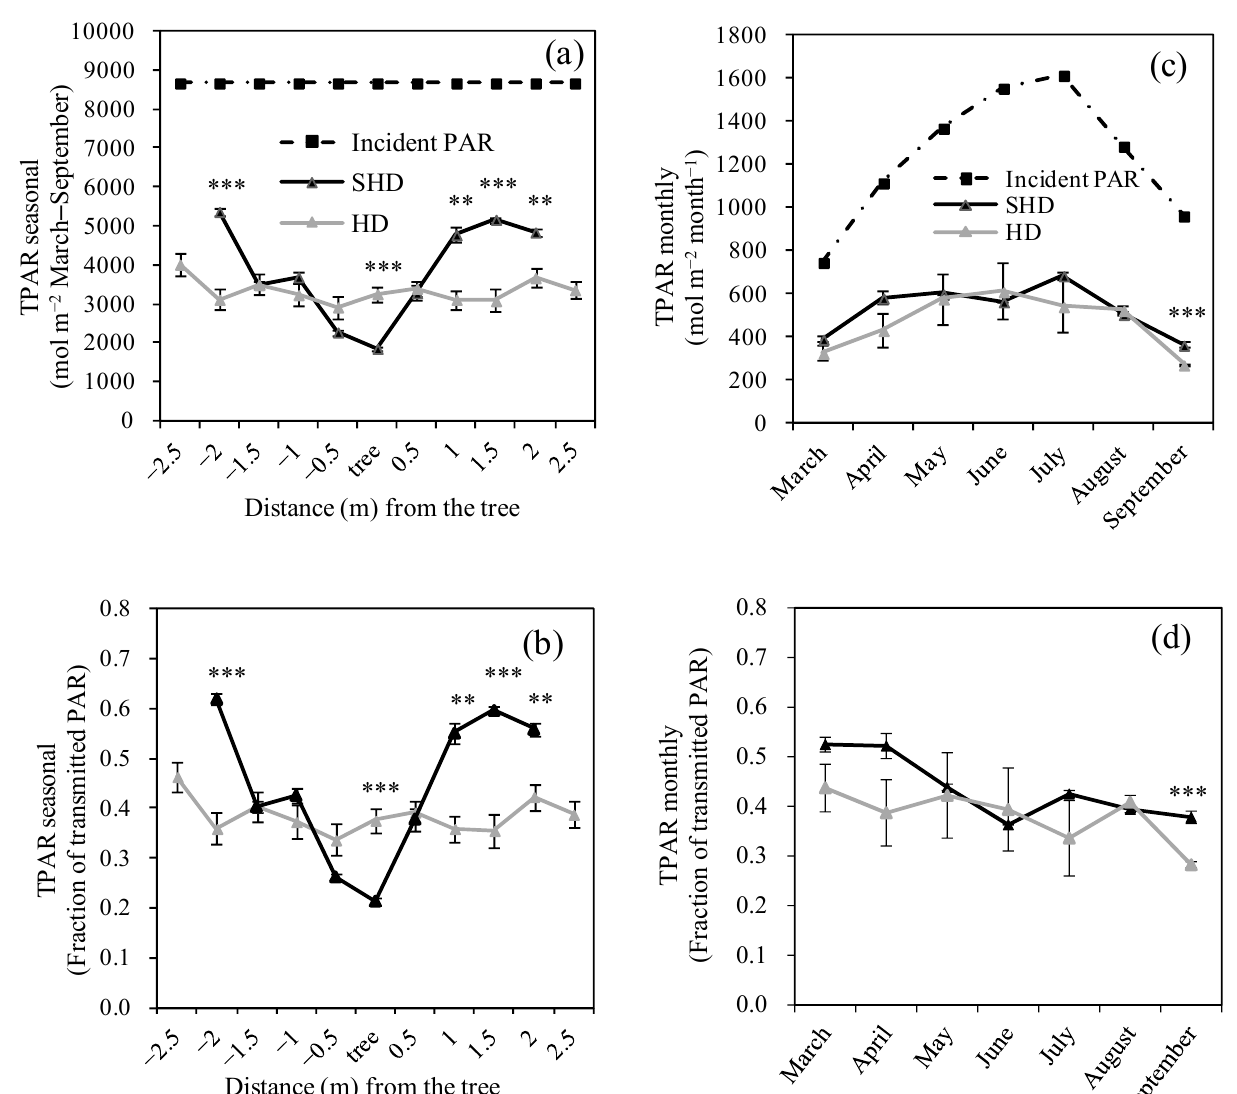
Figure 2. Seasonal (March–September) transmitted photosynthetically active radiation (TPARseasonal) in a high-density (HD) and a super high-density (SHD) systems at increasing distance (0.5 m steps) from the tree row, on both the east (negative distances) and west (positive distances) side, up to the middle of the alleys (i.e., at 2 and 2.5 m from the tree row, respectively for the SHD and the HD systems), expressed ( a ) in absolute terms and ( b ) relative to the photosynthetically active radiation (PAR) incident above the canopy obtained from a weather station. Monthly transmitted PAR (integrated over the different transect positions, TPARmonthly) expressed ( c ) in absolute terms and ( d ) relative to the PAR incident above the canopy. Values are means of 4 replications; bars indicate standard errors. Statistical significance between systems, within each position, was tested by analysis of variance (ANOVA, * = p < 0.05; ** = p < 0.01, *** = p < 0.001). For details on calculations of monthly transmitted PAR, see materials and methods, Section 2.2.